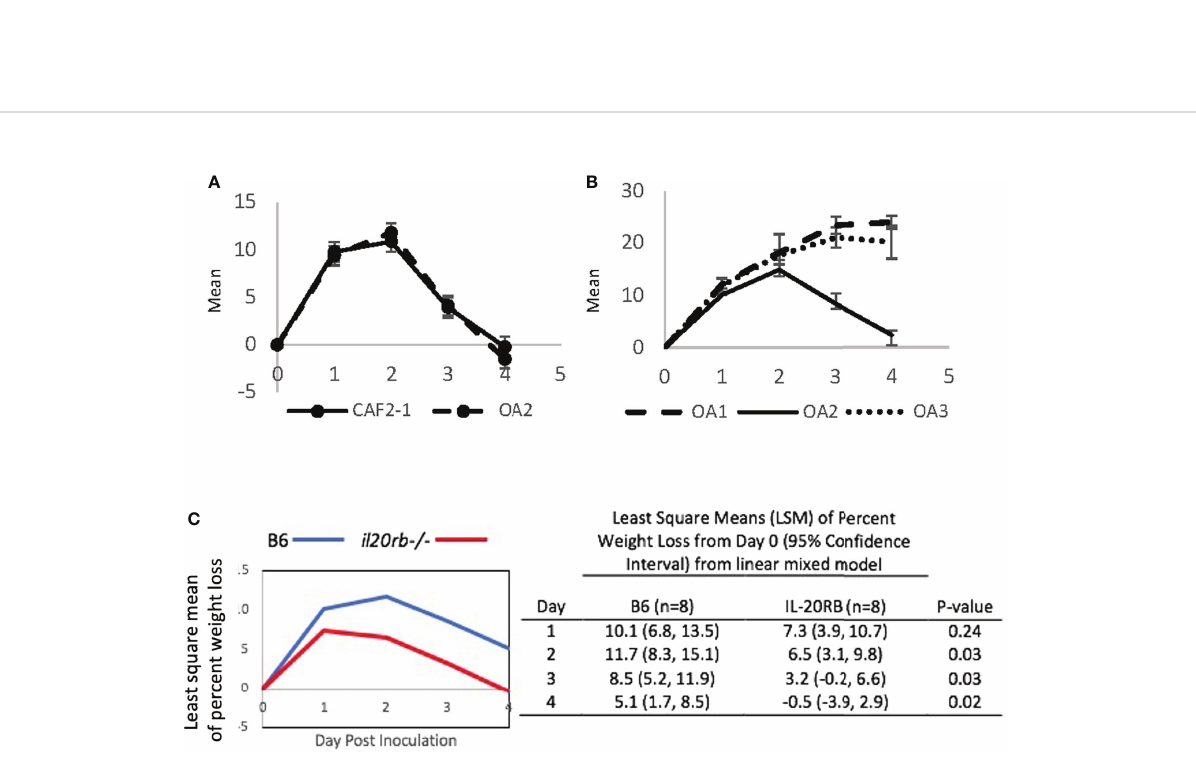
FIGURE 4 Mean percent loss in body weight caused by oral-adapted (OA) CAF2-1 lineages in wild-type B6 mice during acute oral candidiasis, relative to Day 0 post-inoculation. (A) The weight loss pro fi le of OA2 was identical to that of the parental strain CAF2-1. (B) OA1, OA2, and OA3. Differences between OA1 and OA2, and OA3 and OA2 were statistically signi fi cant on Days 3 and 4 post inoculation ( P < 0.01). Each experiment was performed once with an N = 4. (C) Percent weight loss relative to Day 0 in il20rb -/- and wild-type B6 mice after inoculation with C. albicans strain OA1. Mice de fi cient in the IL-20RB receptor (red) exhibited reduced weight loss on Days 2, 3, and 4 during oral candidiasis compared to wild-type B6 mice (blue), matched for age and gender. See the Materials and Methods section for a description of the statistical analysis. The raw data are provided in Supplementary Table S2.